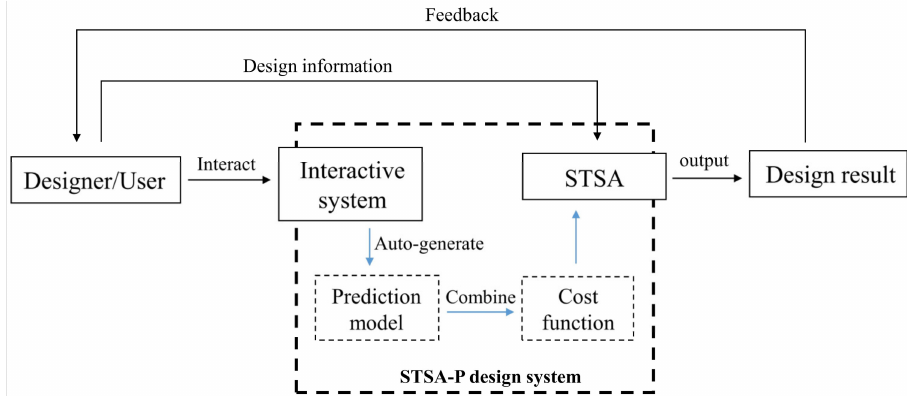
Figure 11. Design process based on